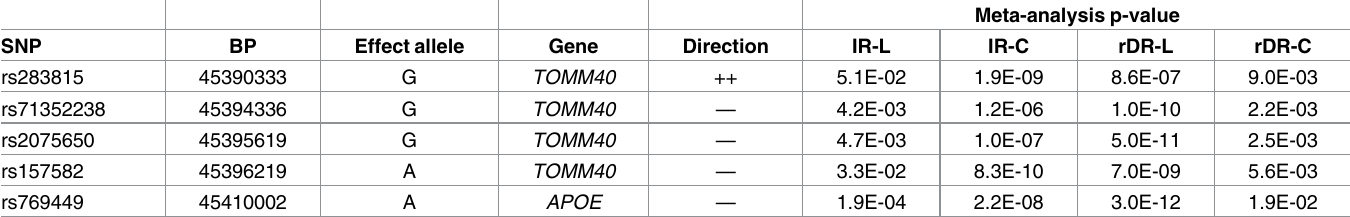
Table 4. Meta-analyses results for SNPs reaching genome-wide significance for all four phenotypes: Immediate recall level (IR-L), immediate recall change (IR-C), residualized delayed recall level (rDR-L), and residualized delayed recall change